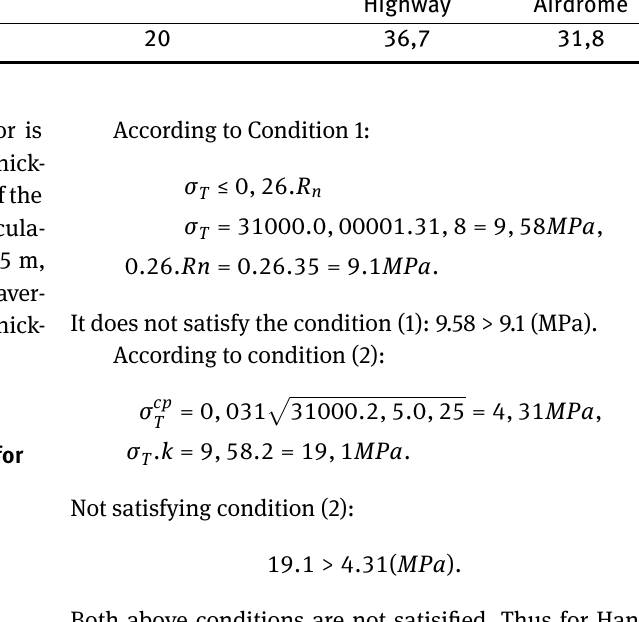
Table 1: Average temperature deviation in the middle of the slab’s thickness T ∘ C Surface,